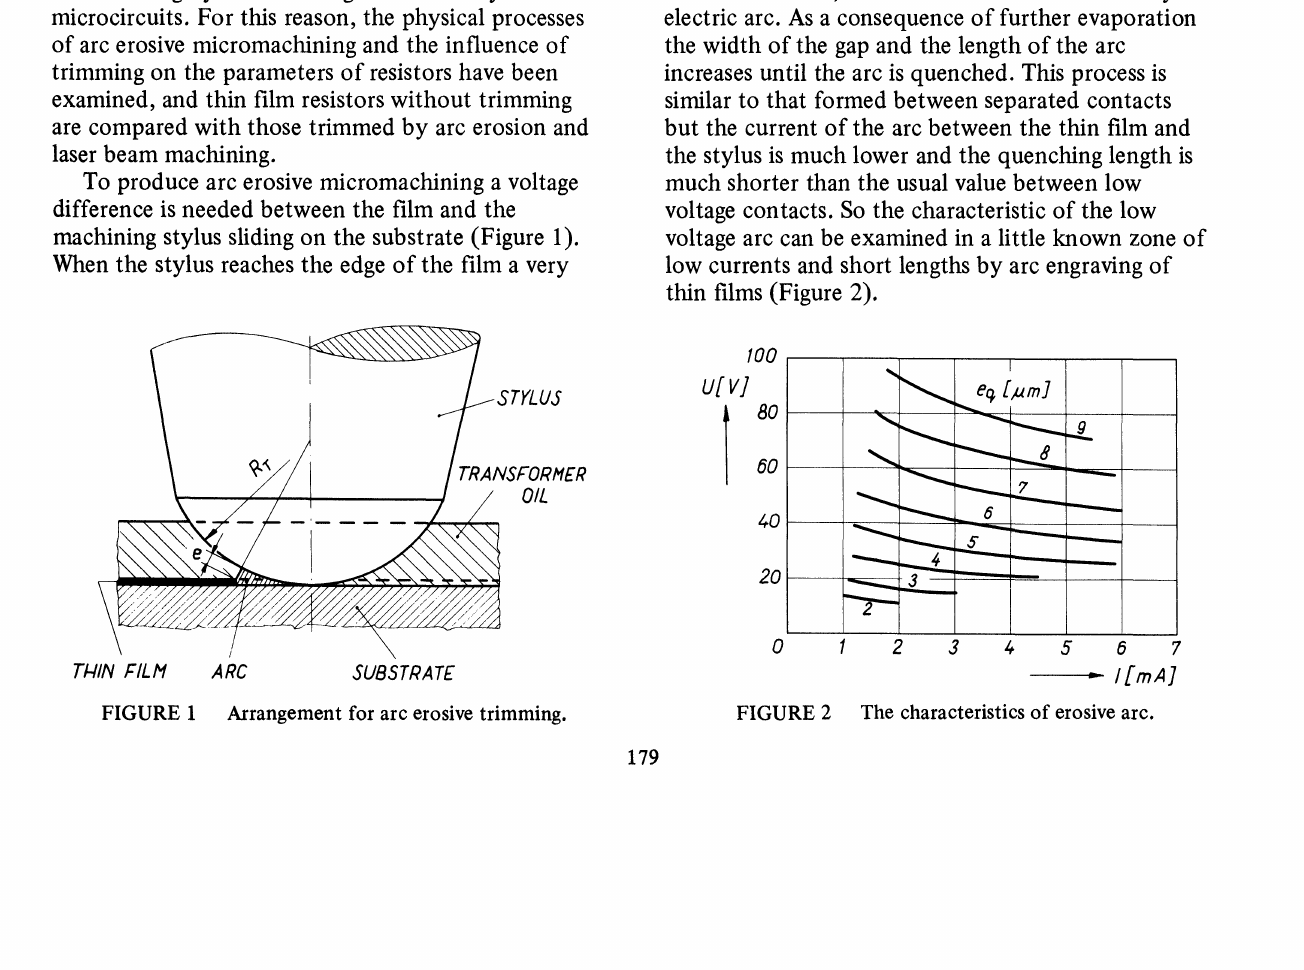
Arrangement for arc erosive trimming.